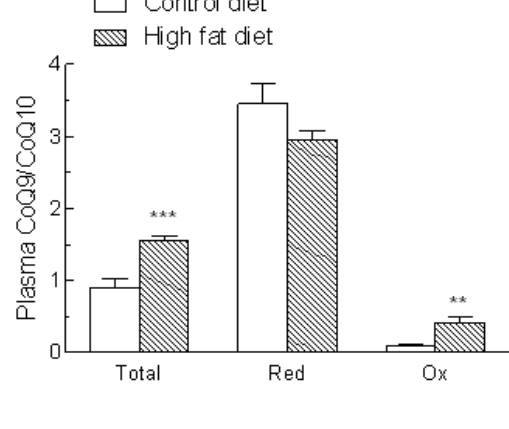
Figure 4. Plasma CoQ9:CoQ10 ratios in rats fed a standard low fat (Control diet) or a high fat diet for 18 weeks. Blood samples were collected and the concentrations of reduced (RedCoQ) and oxidised (OxCoQ) CoQ9 and CoQ10 in plasma were measured and the ratio of CoQ9:CoQ10 was calculated. Data are the mean from 6 (Control diet) or 10 (High fat diet) animals and error bars show the SEM. ** P < 0.01, *** P < 0.001 vs. Control